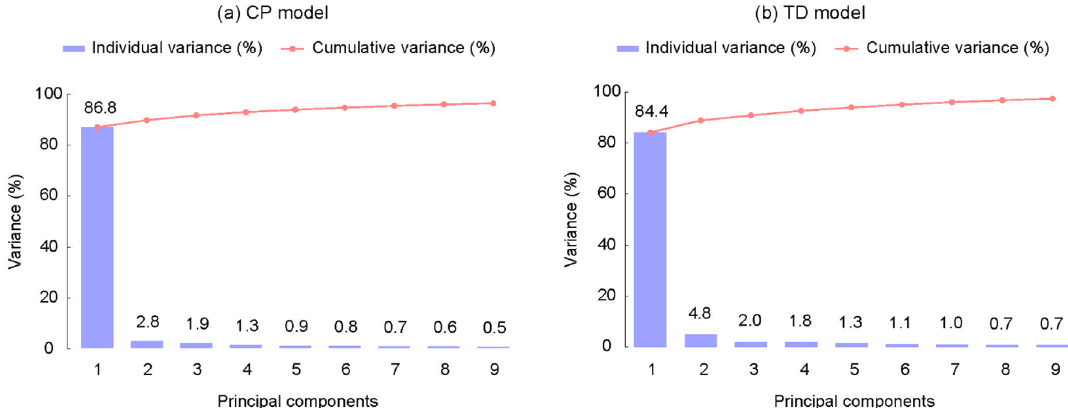
Figure 2. The first 9 PCs of the CP and typically developed (TD) morphological models and their cumulative